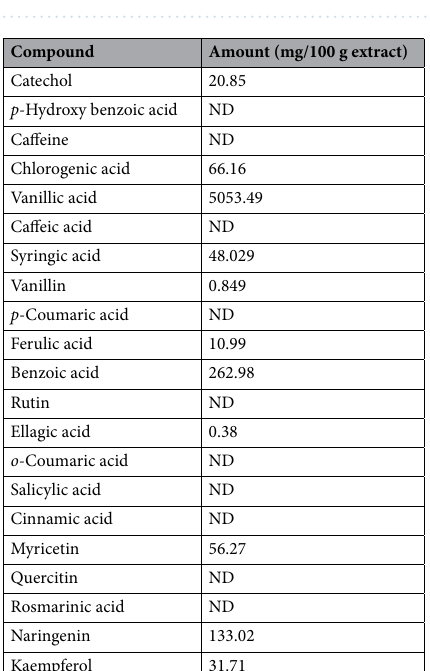
Figure 3. HPLC fingerprint of the identified phytoconstituents in M. oleifera SRRP extract.